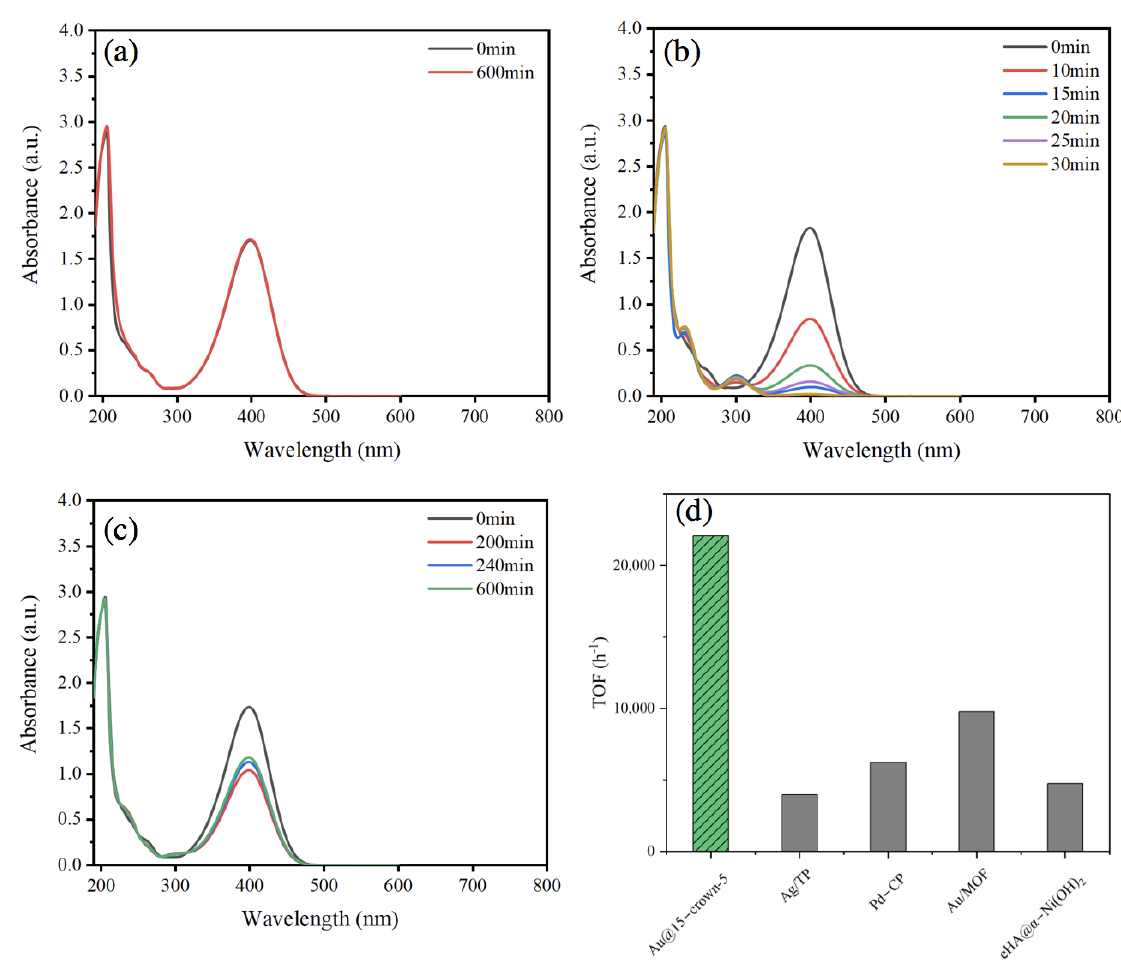
Figure 6. Catalytic reaction properties of Au@15-crown-5: ( a ), NaBH 4 + 4-NP; ( b ), NaBH 4 + 4-NP + Au@15-crown-5 catalyst at different time intervals up to 30 min; ( c ), NaBH 4 + 4-NP + Au@15-crown-5 catalyst at different time intervals up to 600 min; and ( d ) comparison of catalytic performance of other catalysts and this work.